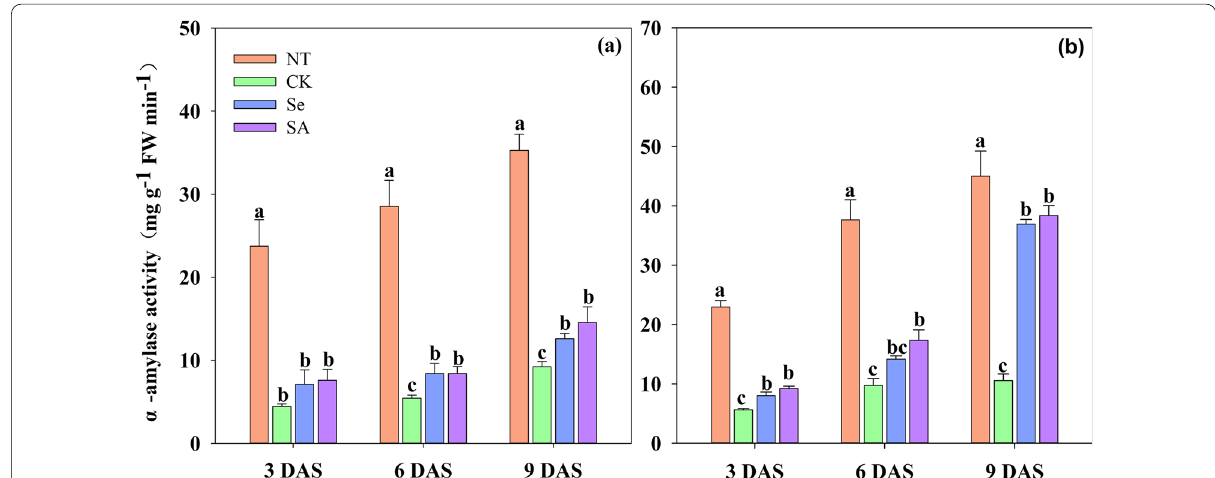
Fig. 2 Changes in α-amylase activity of primed and non-primed rice seeds under control temperature and chilling stress. a EZ18. b LY287. DAS, days after sowing; EZ18, ezao18; LY287, liangyou287; NT, no priming-normal temperature control; CK, no priming-chilling stress; Se, Selenium priming-chilling stress; SA, Salicylic priming-chilling stress. Error bars indicate standard error (n differences at the 5% level according to LSD test among four treatments within the same DAS of the same